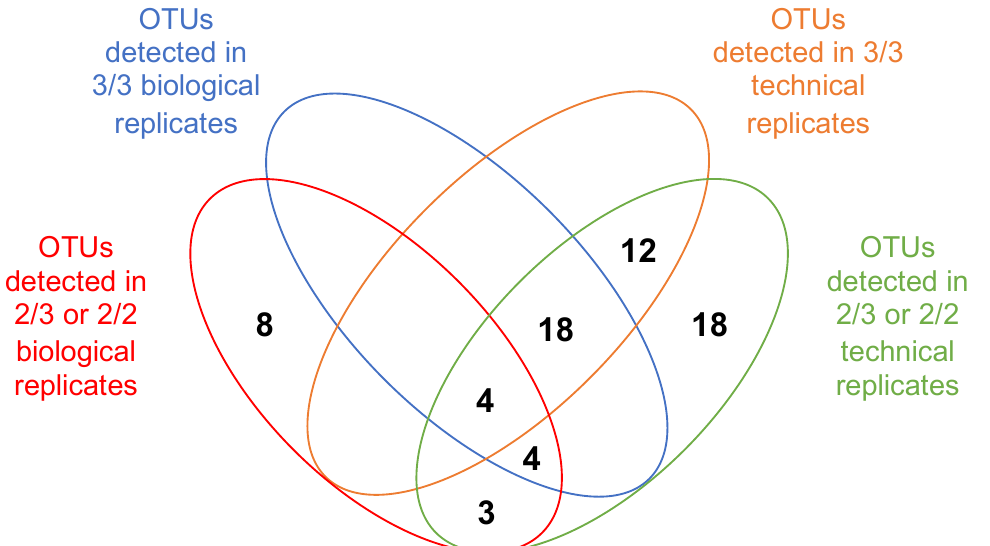
Figure 5. Comparing the influence of the epicPCR replicate strategies on OTU detection. This Venn diagram presents the distribution of the 67 validated OTUs resulting from the taxonomic assignment of SXT/R391 elements in bacteria from the Meurthe River water according to the methodologies used and presented Figure 4 and Supplementary Table S3. The bias toward detecting more OTUs in technical replicates is revealed by the high OTU numbers in the corresponding ellipses.